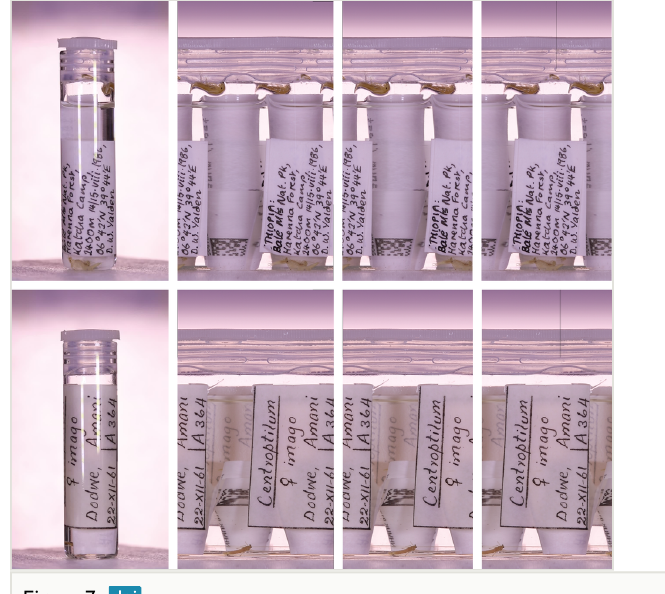
ReVILE: Two Rollout photography outputs of ReVILE. Left to right: a frame from the video (rotated 90° clockwise) showing the vial itself; the uncropped rollout image, covering more than one full rotation; the cropped rollout image, showing only one 360° rotation; the cropped rollout image, "shifted" across (by transferring a manually-defined block of pixel columns from the left side of the image to the right) to show the complete